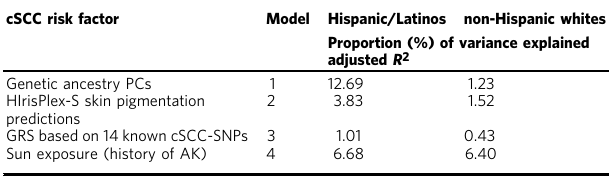
Table 3 Variances explained by each cSCC risk factor.